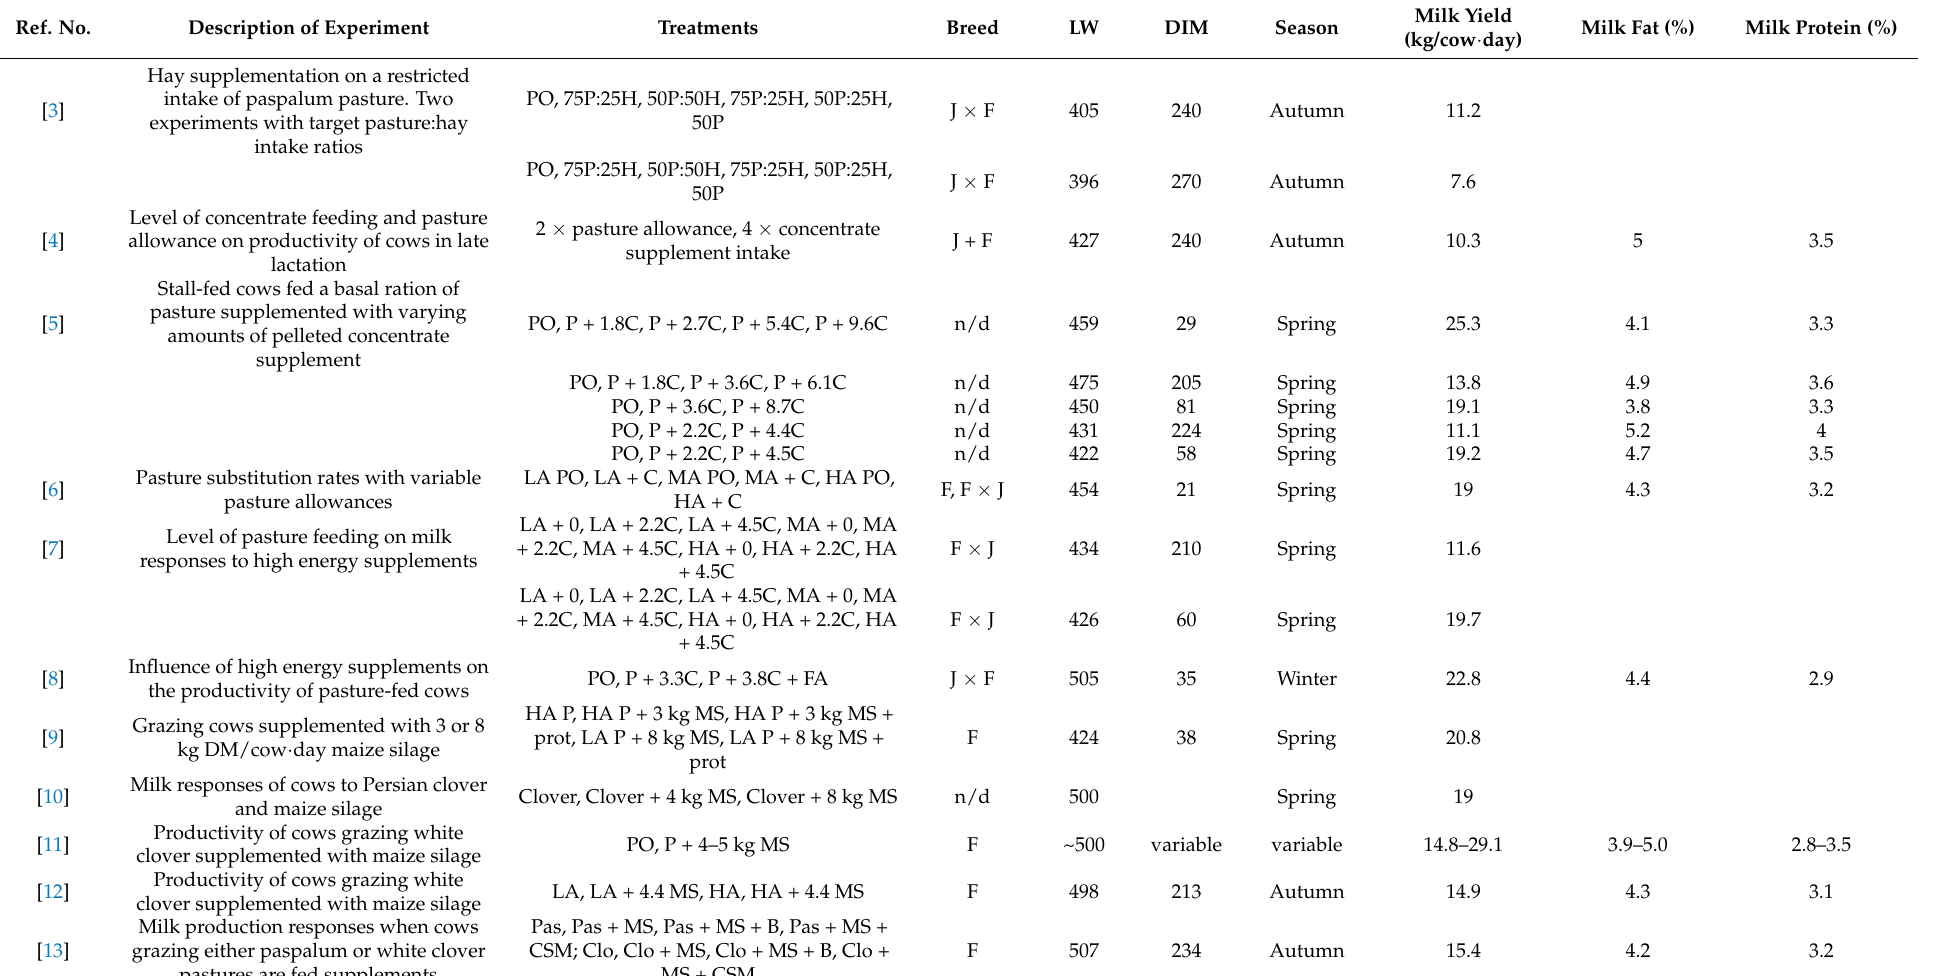
Table 1. Summary of experiments contributing to the